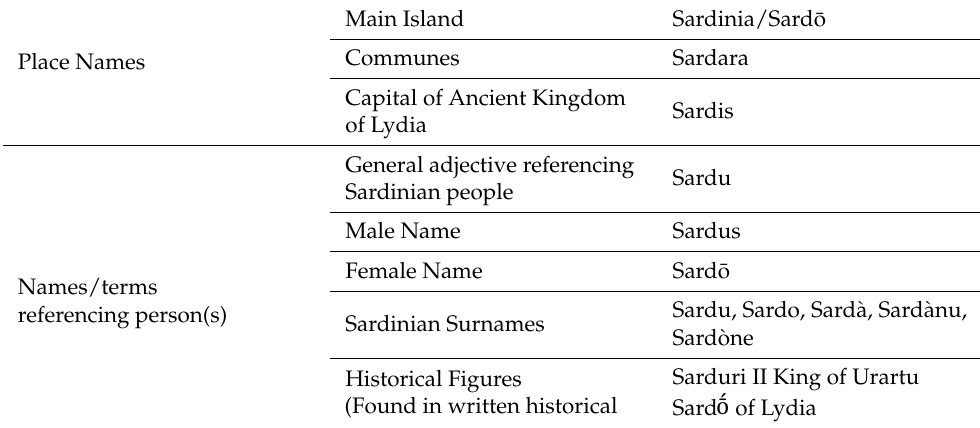
Table 1. Related names containing root *s(a)rd- (Dedola 2015; Dedola n.d.).